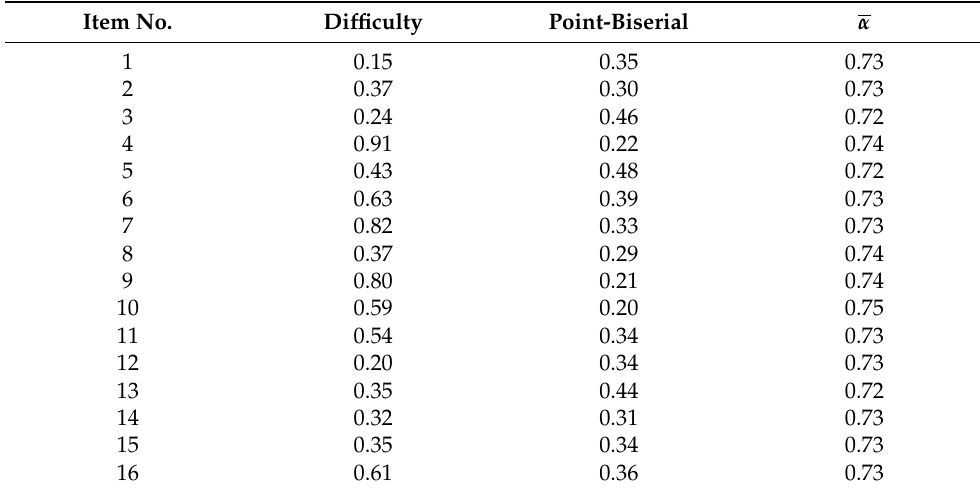
Table 2. Each item’s difficulty and point-biserial-coefficent, as well as the adjusted Cronbach’s ¯ α if the respective item is dropped. See text for details.